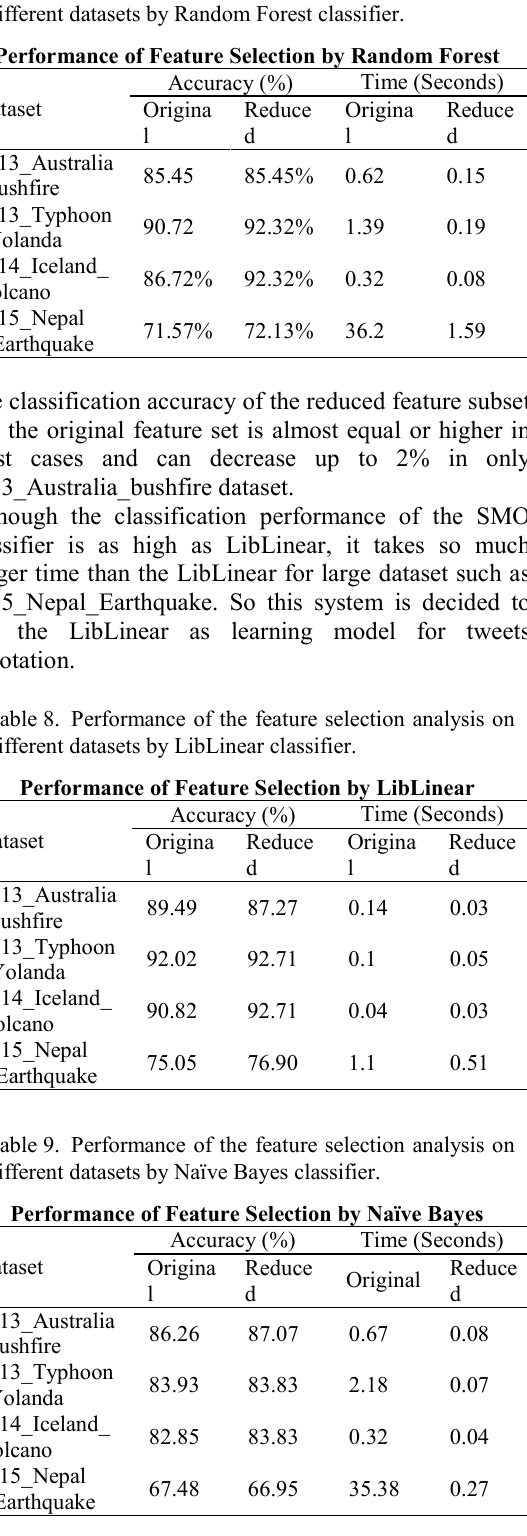
Table 7. Performance of the feature selection analysis on different datasets by Random Forest classifier.